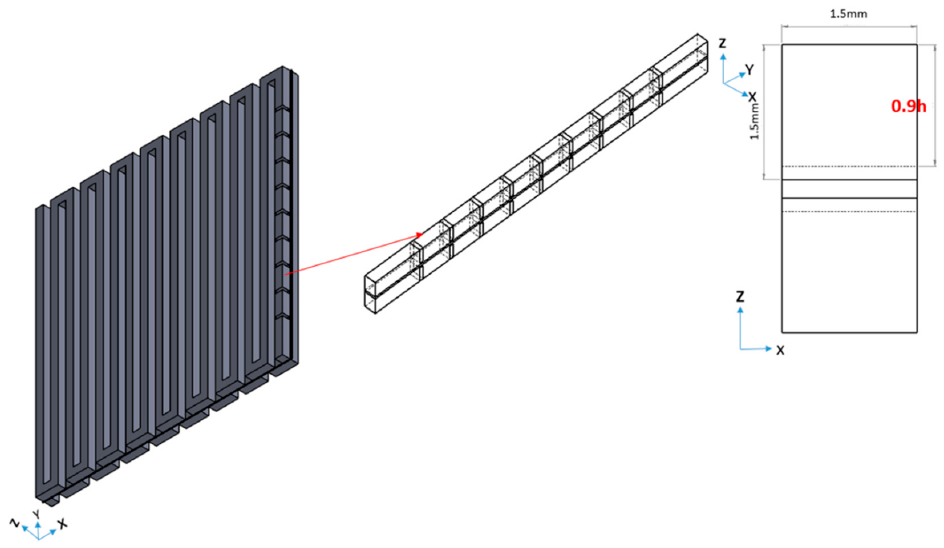
Figure 6. Three-dimensional model of a VRFB with baffle array.